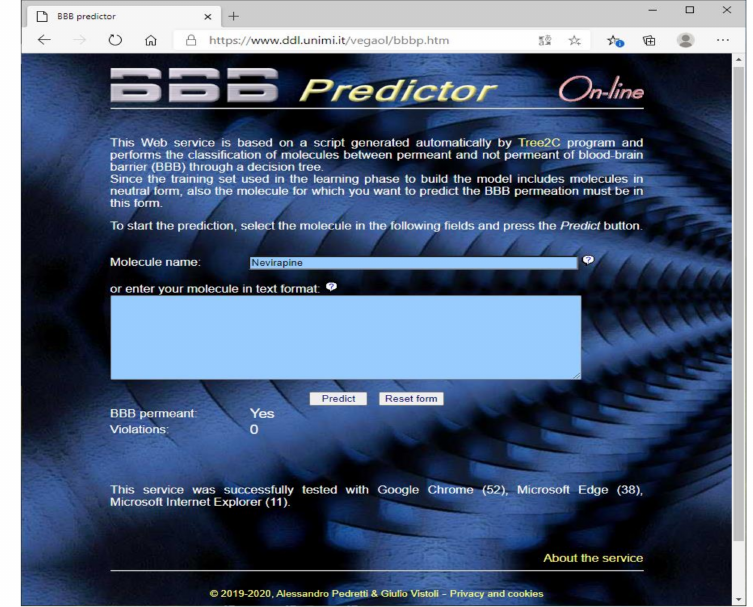
Figure 2. The graphic interface of the web service based on the code generated by Tree2C to predict the BBB